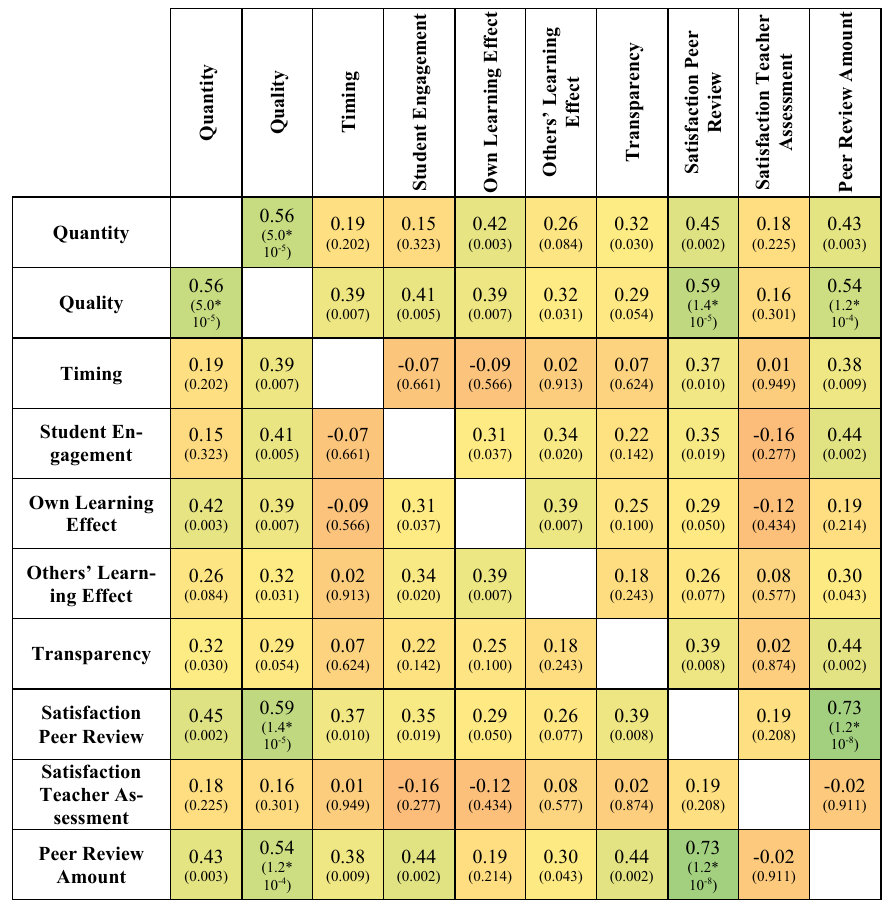
Table 1. Spearman correlation coefficients of analyzed learning factors (Java EE